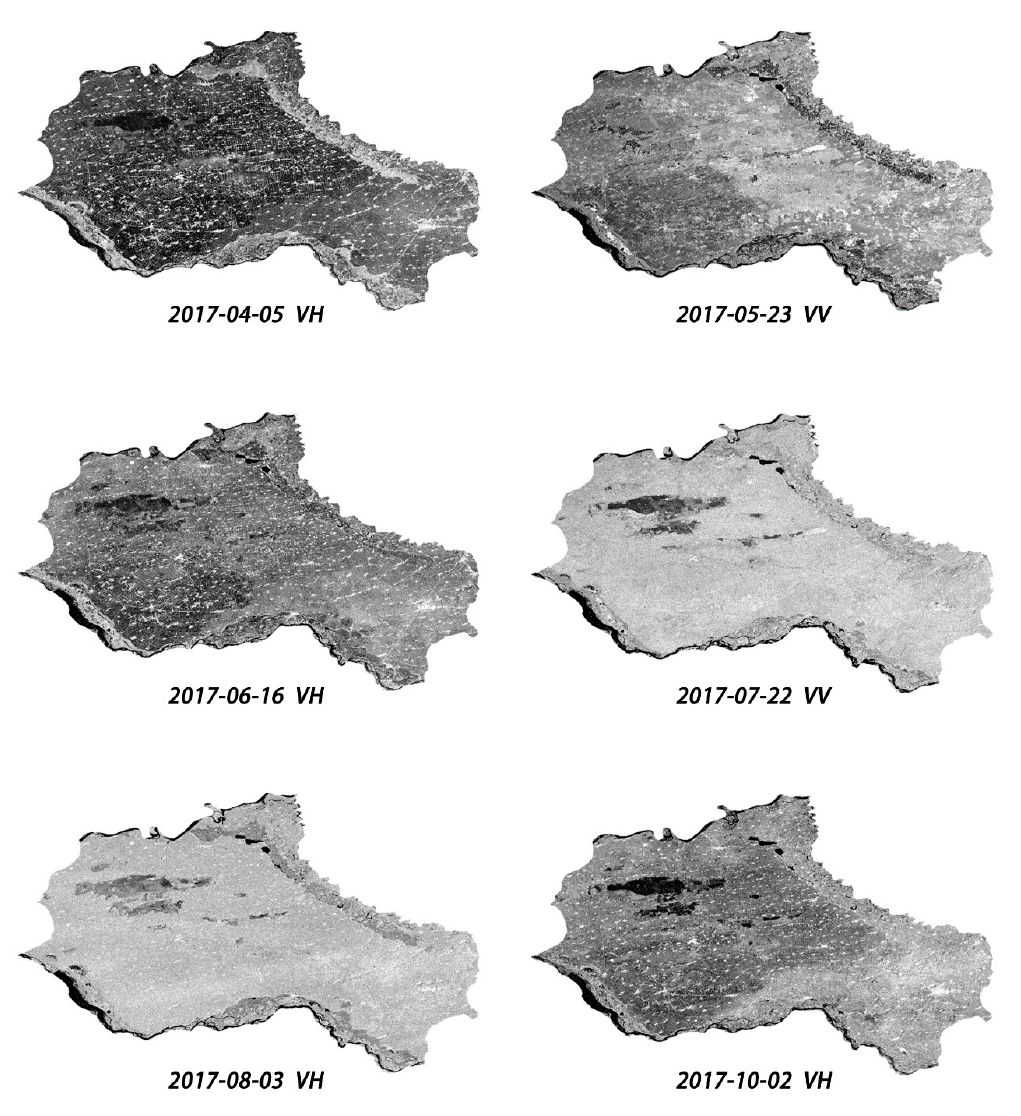
Figure 7. The optimal multi-temporal images.